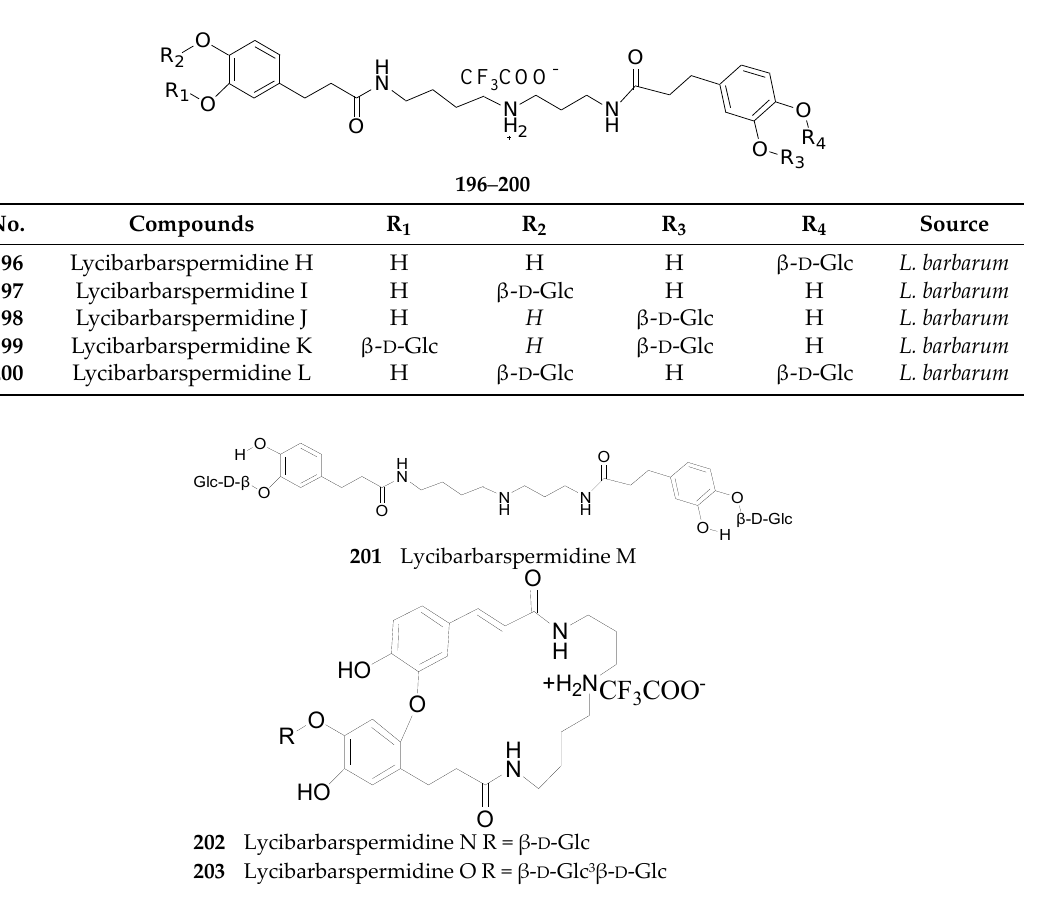
Figure 14. Chemical structures of compounds 194 and 195 . Table 10. Chemical structures of compounds 196 – 200 . Table 10. Chemical structures of compounds 196 – 200 .